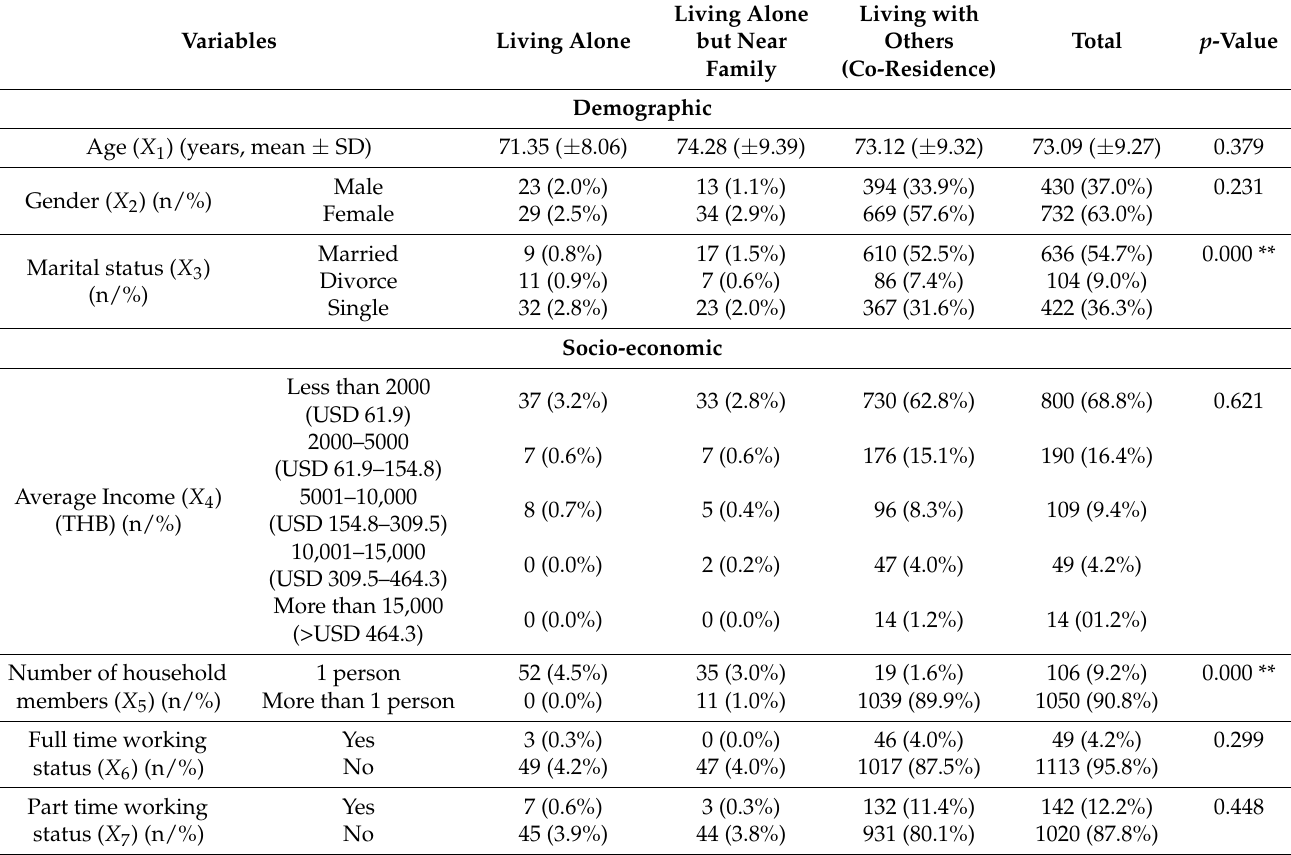
Table 2. The demographic and socio-economic characteristics of older